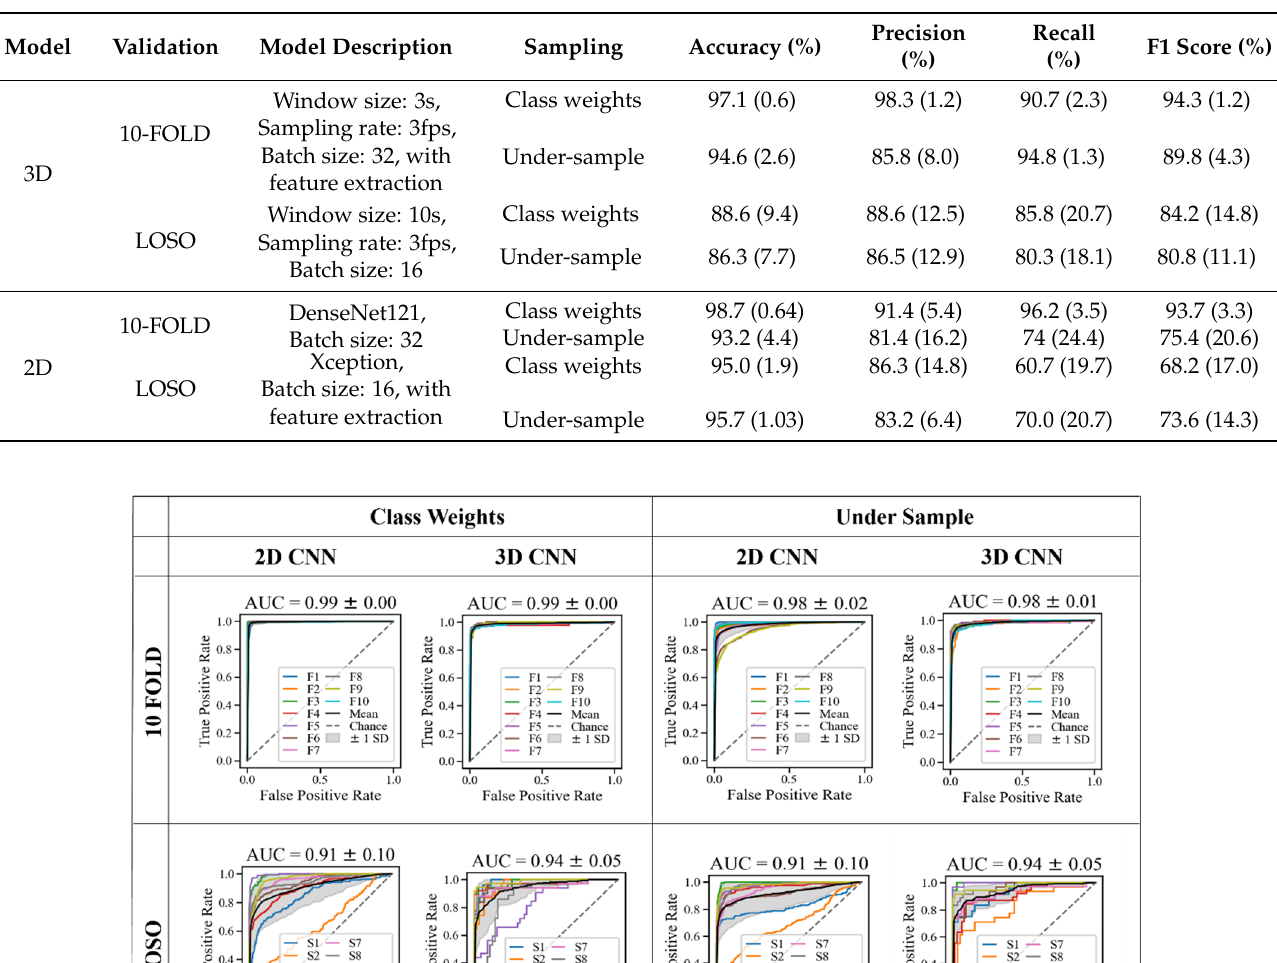
Table 2. Performance metrics for the best models. The values in the brackets represent the standard deviations for each metric across the folds.